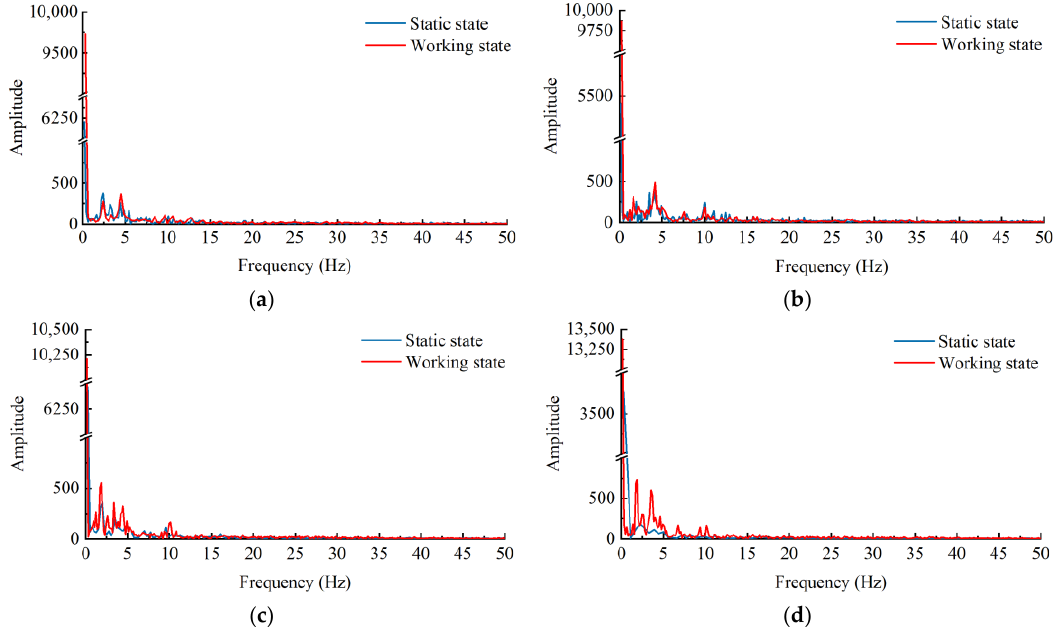
Figure 7. Spectrum diagram of torque signal at different running speeds: ( a ) 3.17 km/h; ( b ) 4.14 km/h; ( c ) 5.57 km/h; ( d ) 7.13 km/h.